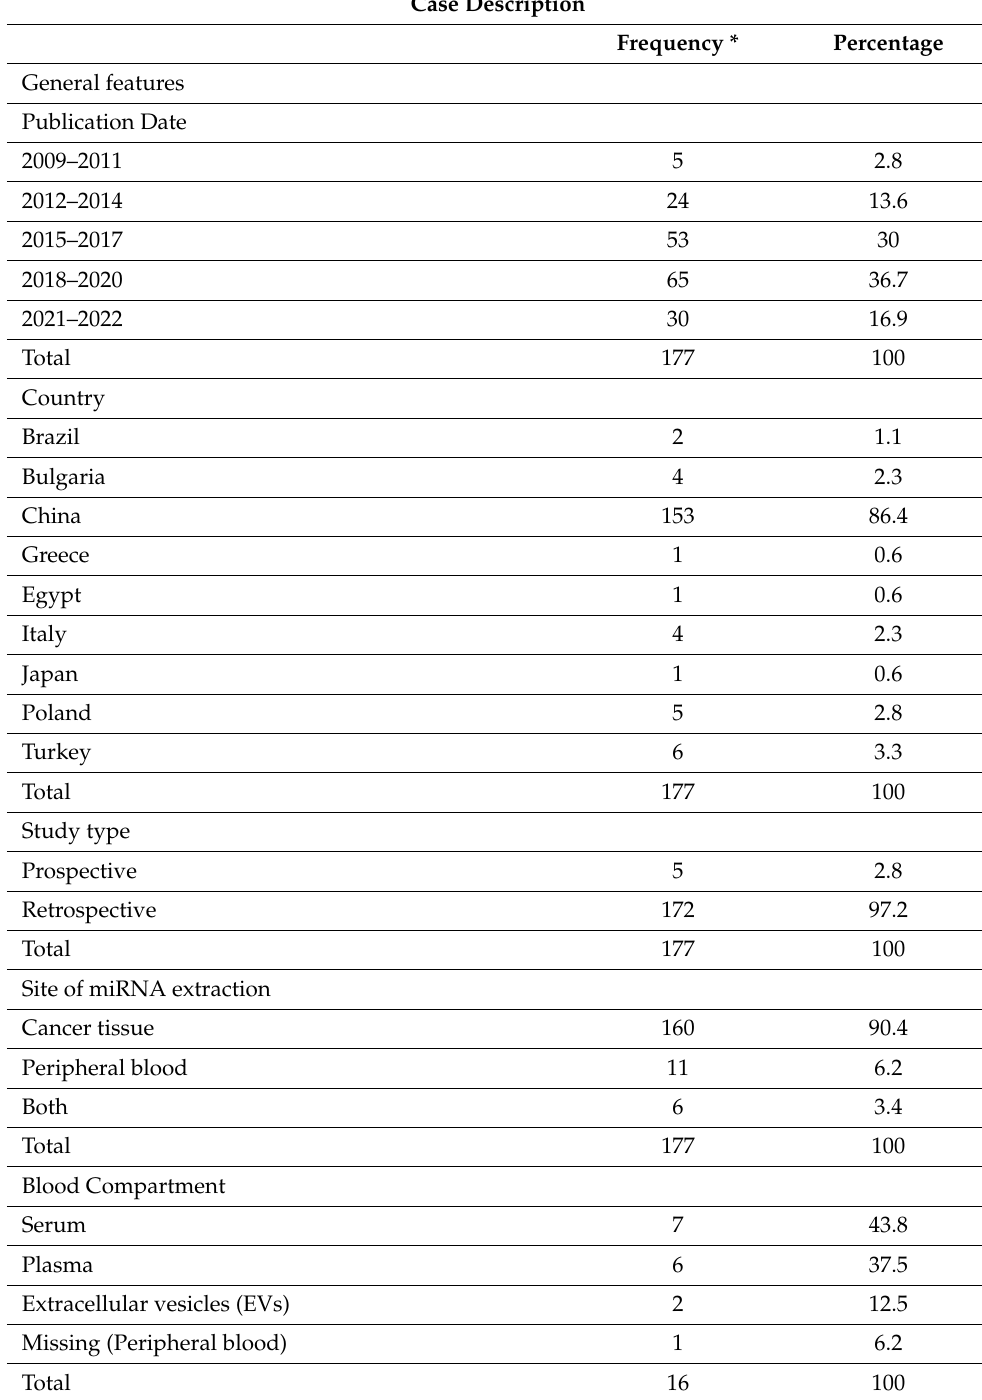
Table 1. Description of general features of the 177 selected studies in this systematic